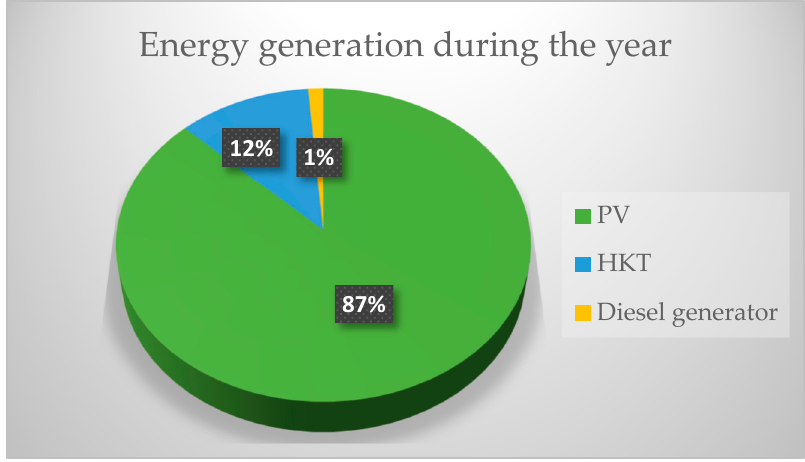
Figure 11. Percentage composition of the yearly energy generation of the HRES.